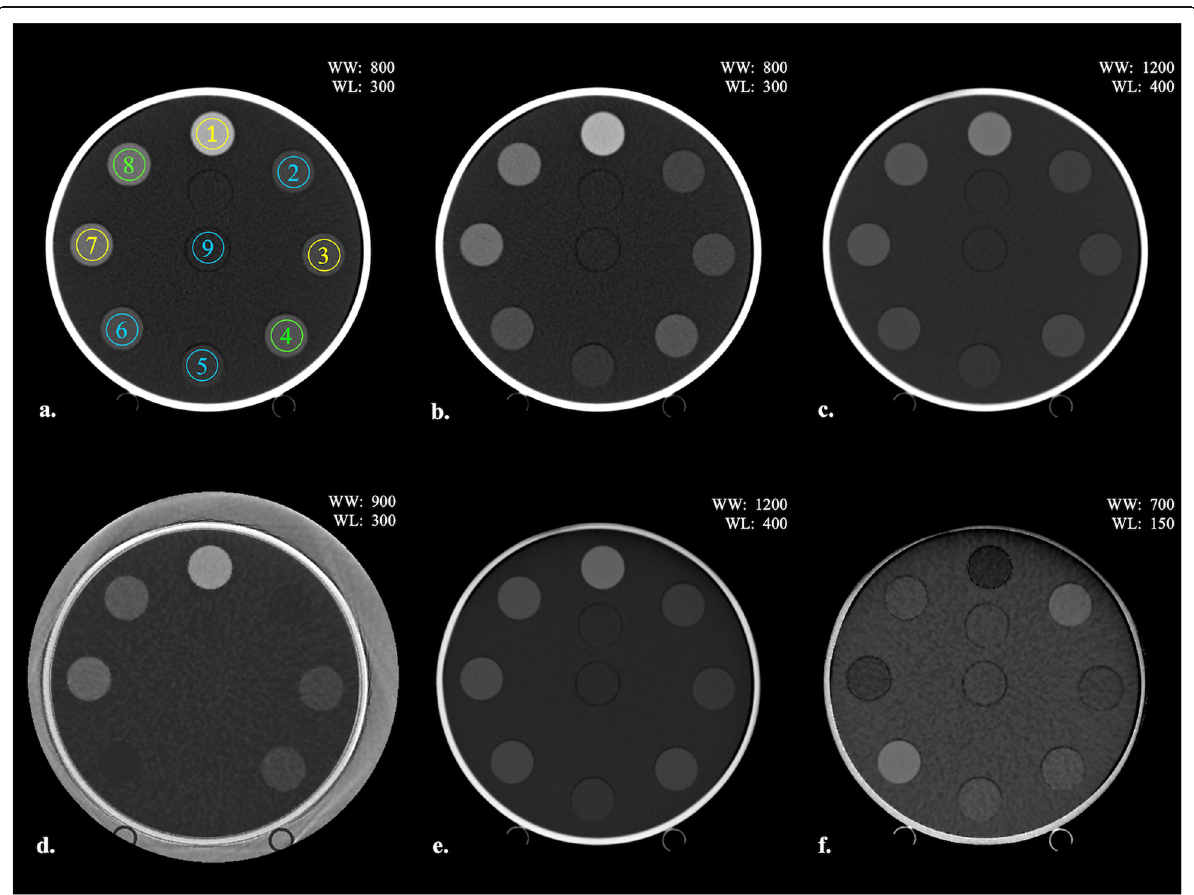
Fig. 2 Positions of the regions of interest (ROIs) for measuring computed tomography (CT) values in multi-energy CT phantom image and CT images. a All ROIs lie in the same area, which corresponds to 70% of the regional area. Assuming brain CT imaging, 9 ROIs were set; ROI_1, ROI_3, and ROI_7: Iodine concentration [mg/mL] of 10.00, 2.00, and 5.00 (yellow circles); ROI_2, ROI_5, ROI_6, and ROI_9: Soft tissues as the blood ( ρ ew = 1.07), brain ( ρ ew = 1.02), blood ( ρ ew = 1.10), and water ( ρ ew = 1.00) (blue circles); ROI_4 and ROI_8: Mixture of the iodine and blood (2.00 mg/mL + the blood and 4.00 mg/mL + blood) (green circles). b Single-energy image (80 kVp). c Single-energy image (135 kVp). d Iodine map. e Virtual monoenergetic image, F Virtual non-contrast